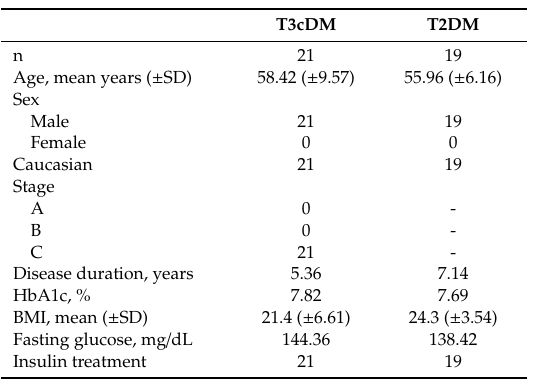
Table 2. Patient